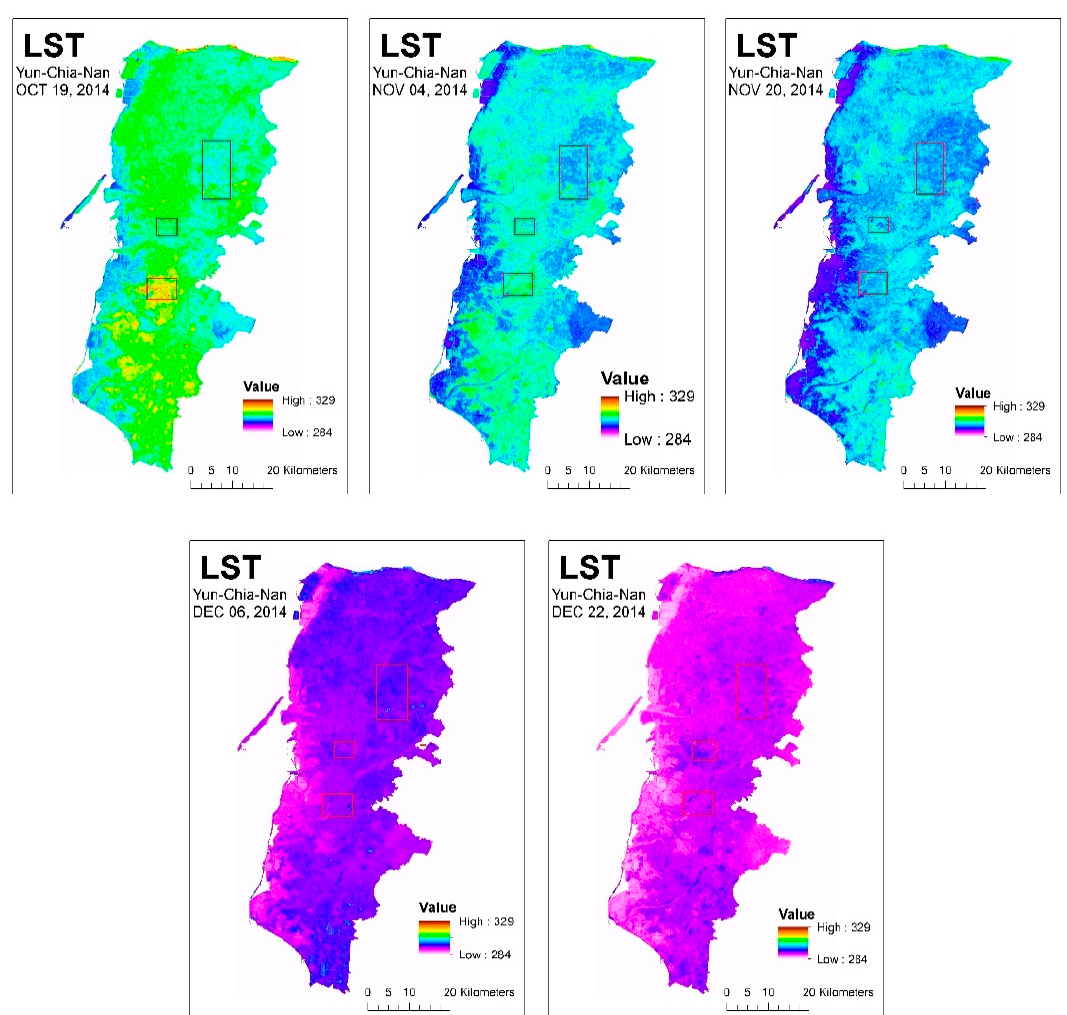
Figure 3. Land Surface Temperature images over Yun-Chia-Nan on 19 October, 4 November, 20 November, 6 December, and 22 December 2014.